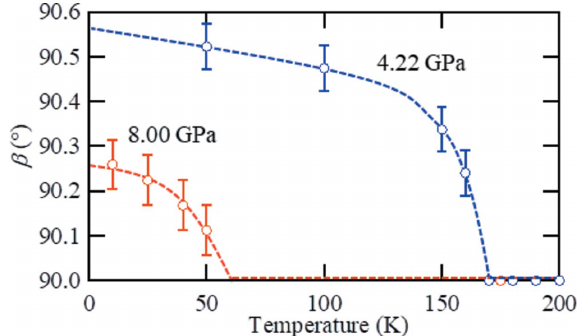
Figure 6 Temperature dependence of the monoclinic angle (cid:3) at 4.22 and 8.00 GPa. The blue and red dashed lines are guides for the